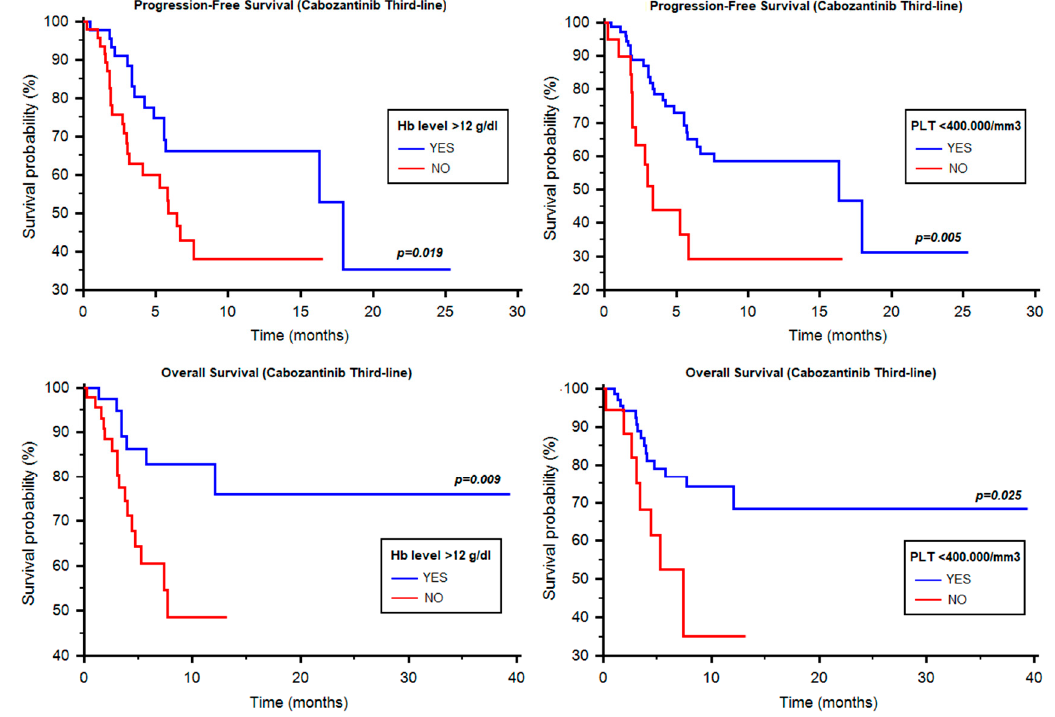
Figure 3. Progression-free survival and overall survival of third-line cabozantinib according to different prognostic factors. Hb = hemoglobin; PLT = platelets.